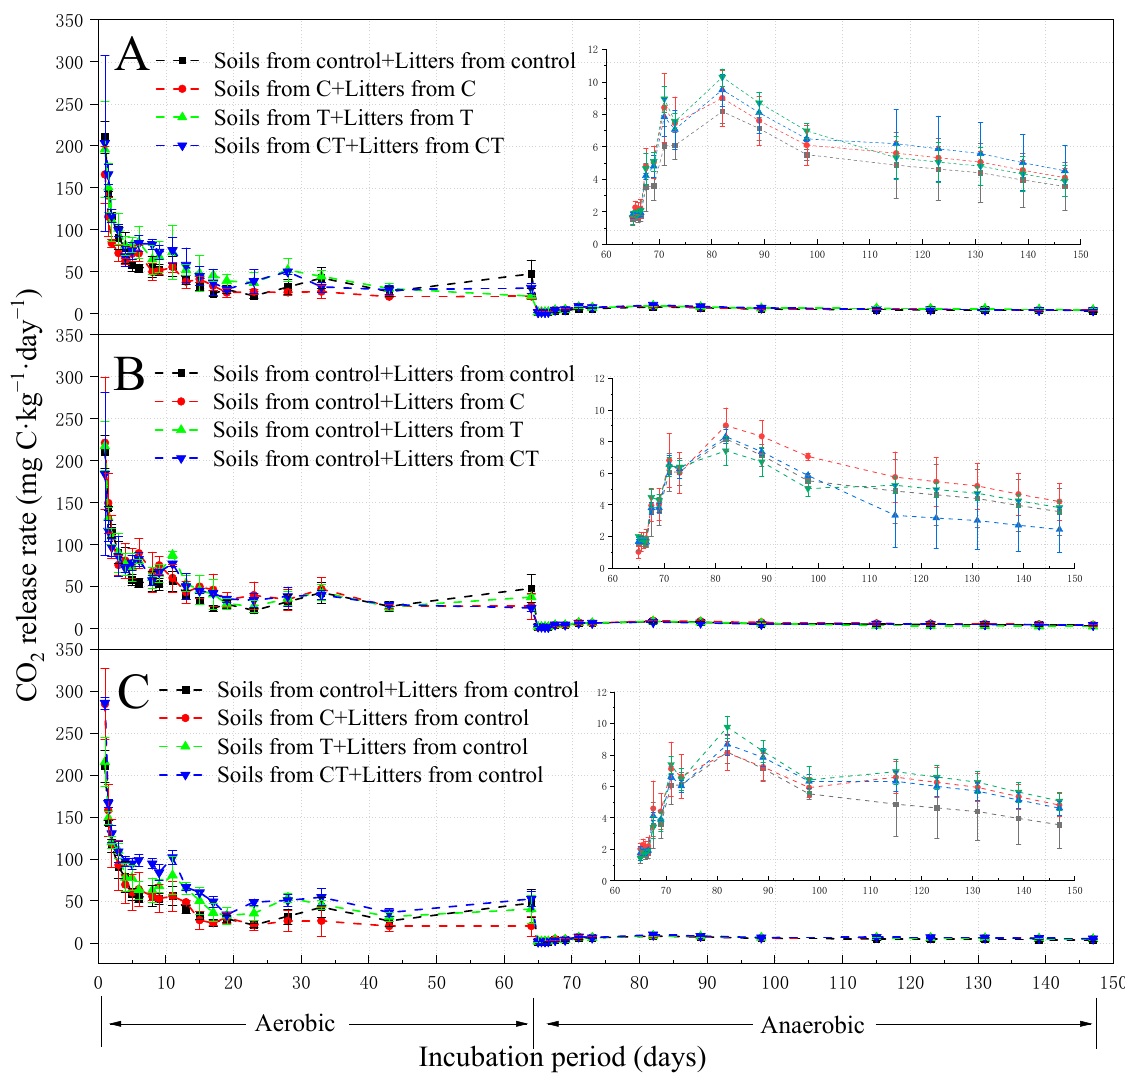
Figure 2. CO 2 released rate during the aerobic and anaerobic stage. Control represents the soils or litter that were collected from the ambient atmospheric CO 2 without warming; C represents the soils or litter that were collected from elevated CO 2 ; T represents the soils or litter that were collected from plant canopy warming; CT represents the soils or litter that were collected from CO 2 plus warming. The letters ( A – C ) represent Experiment I, Experiment II and Experiment III, respectively. The inset represents the period of flooded incubation from Day 65 to Day 147. The cumulative release of CO 2 (soil respiration hereafter) from the soil is shown in Figure 3a. Much more CO 2 was released during the aerobic stage, which accounted for about 90% of the overall release rate. During the aerobic process, elevated CO 2 decreased soil respiration by 27.60% compared to the control, while warming or elevated CO 2 plus warming had no effect on it. During the anaerobic process, all the treatments had no effect on soil respiration.